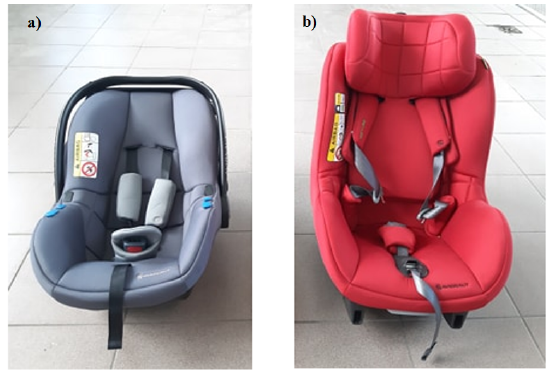
Figure 1: Tested child seats: a) seat for transporting children up to 17.5 kg – “A”, b) seat for transporting children up to 13 kg – “B”